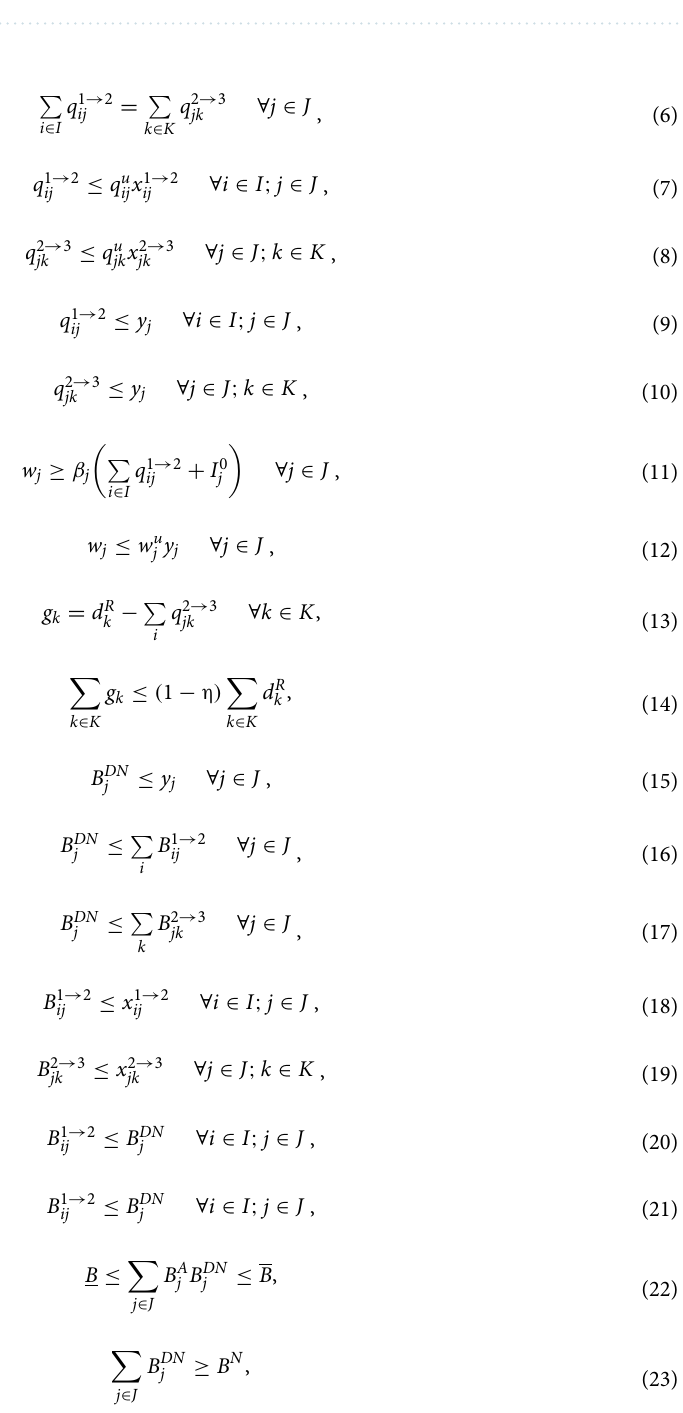
Table 2. Indices, parameters and decision